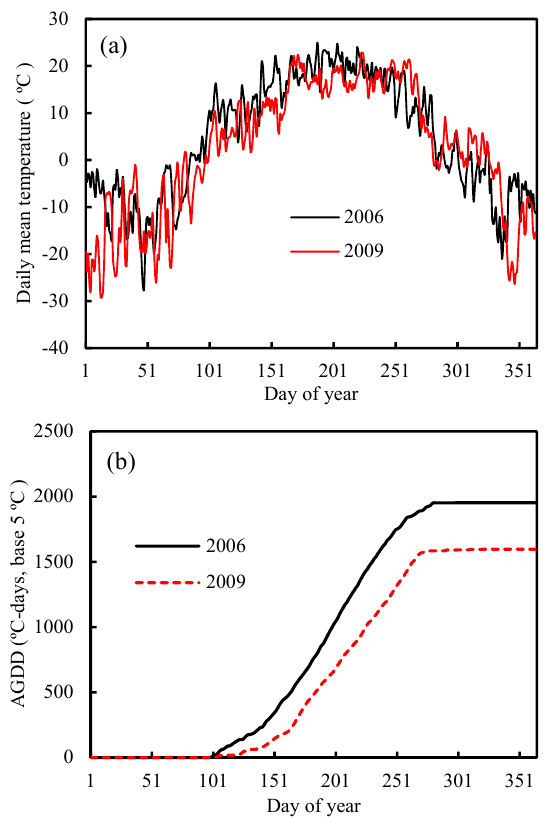
Figure 2. Variability of daily mean temperature ( a ) and accumulated growing degree days (AGDD, °C-days, base 5 °C) ( b ) for the years 2006 and 2009.